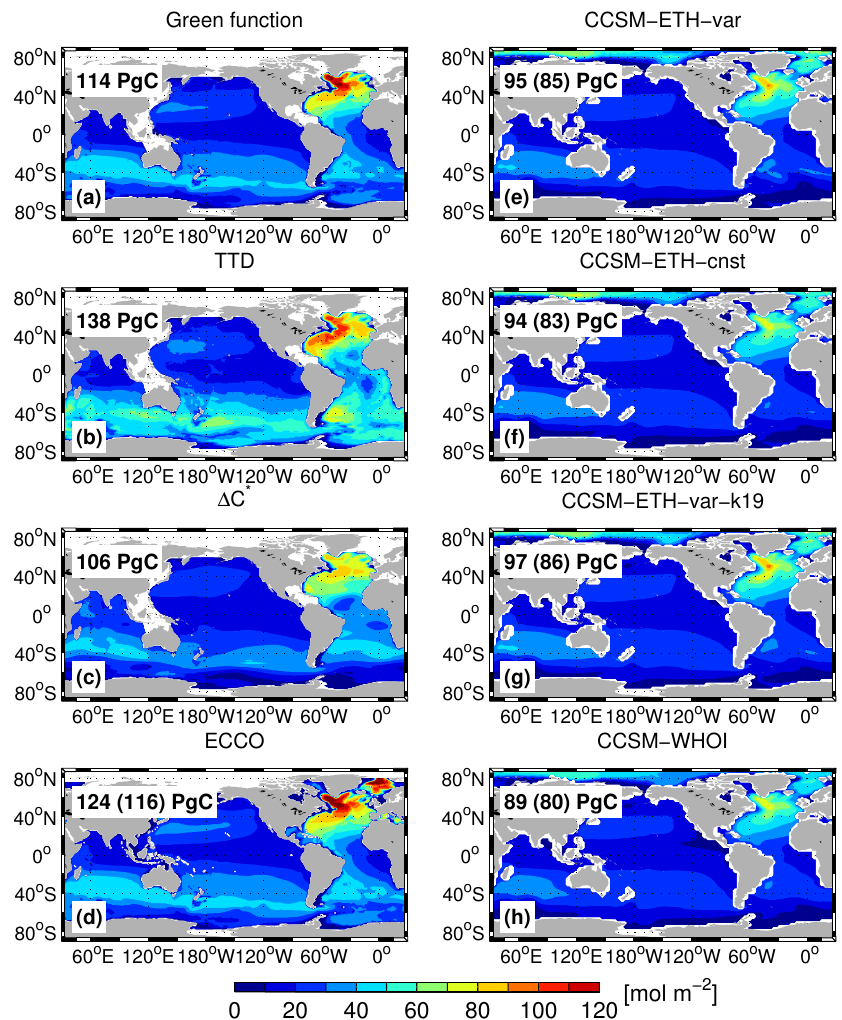
Fig. 2. Column inventory of C ant in mol m − 2 in 1994 based on various data-based methods (panels a – c ) and forward model simulations (panels d – h ). Also indicated on each panel (top left corner) is the C ant inventory in PgC and, for the forward models, the inventory (numbers in brackets) for the region covered by the GLODAP tracer data set on which the observational estimates are based. No downward correction (see text) was applied to the global inventory based on the TTD method.